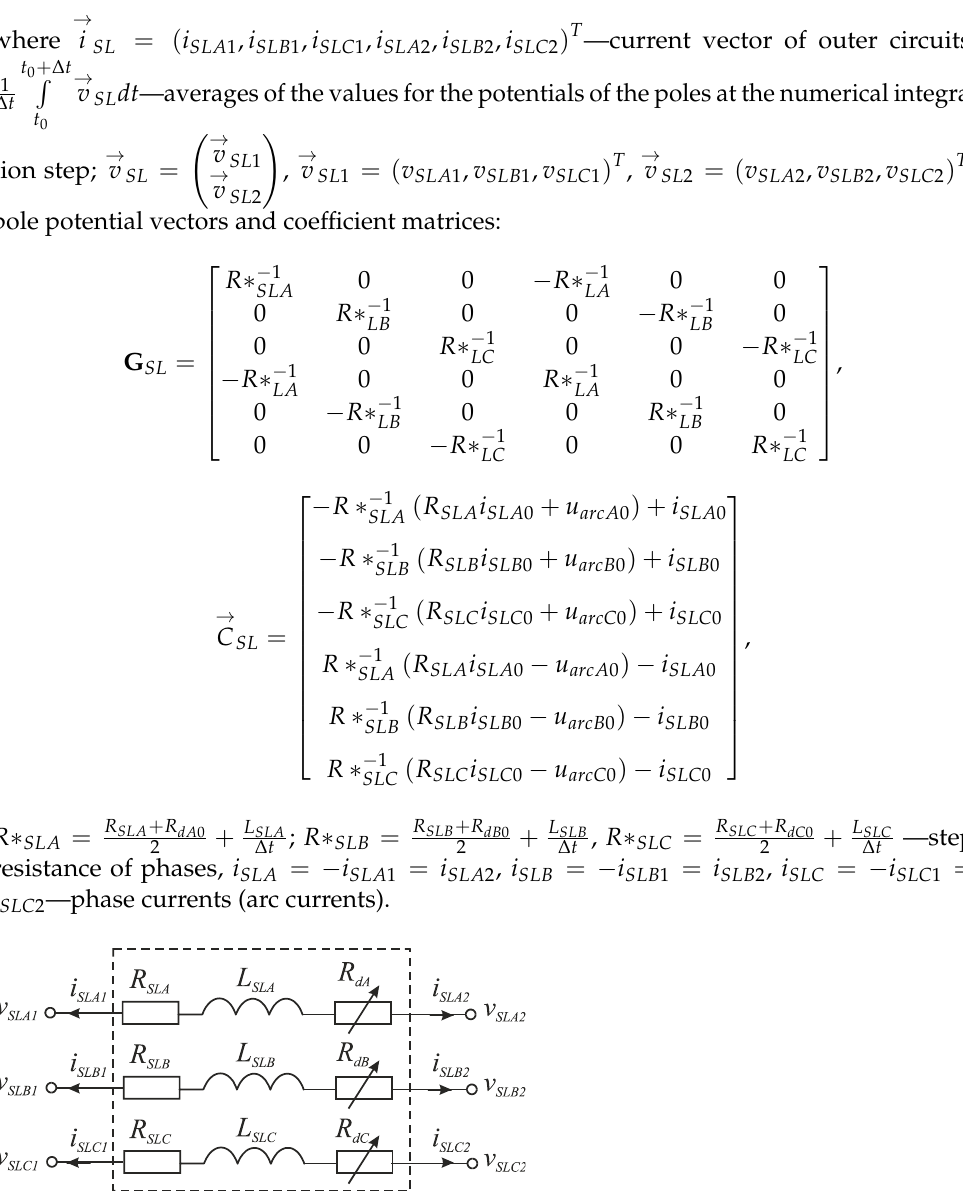
Figure 4. Calculation scheme of a short network with furnace space as six-pole. Equation (17) is used to determine the phase currents in a short network with furnace space (arc currents) according to the dynamic arc resistances, which are determined from approximation Equations (12) and (13), determined with (11) values of arc voltages and power circuit parameters and initial conditions. Mathematical models of a three-phase ) T = i,i,i,i,i,ii where —current vector of outer circuits; SLCSLBSLASLCSLBSLASL 222111 power supply network and a three-phase transformer are described in —averages of the values for the potentials of the poles at the numerical